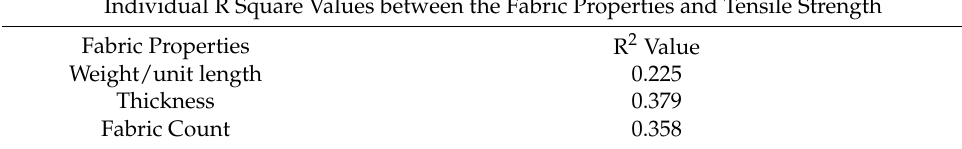
Table 4. Statistical analysis of the tensile strength of the outer layer fabrics exposed in dry condi- tions.